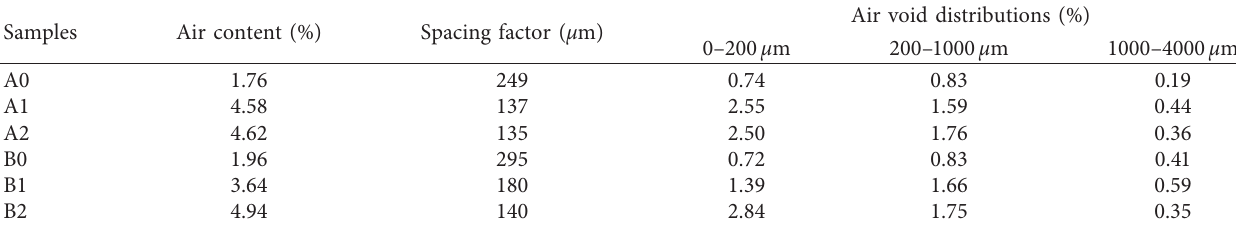
Figure 12: Air void distributions in harden concrete. (a) Concrete without FA; (b) concrete with Table 4: Results of air void characteristic in harden concrete.